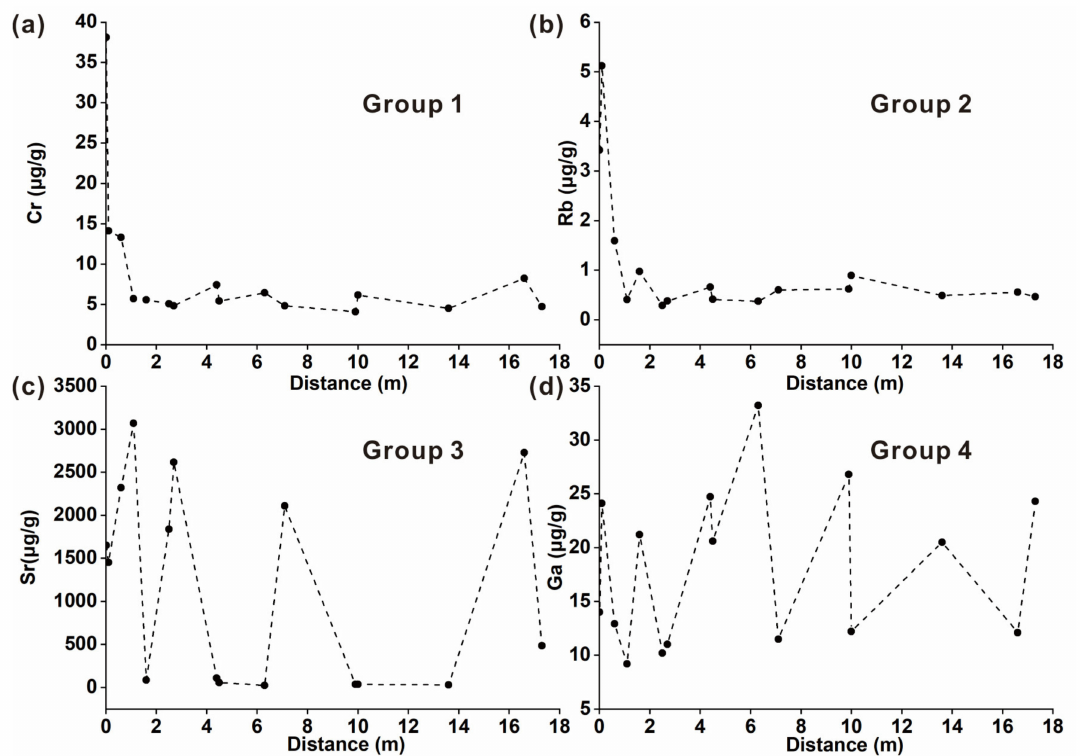
Figure 16. Concentrations of elements in the Tashan coal versus the distance from the dike, elements in the same group exhibit similar trend: ( a ) group 1, represented by Cr; ( b ) group 2, represented by Rb; ( c ) group 3, represented by Sr; ( d ) group 4, represented by